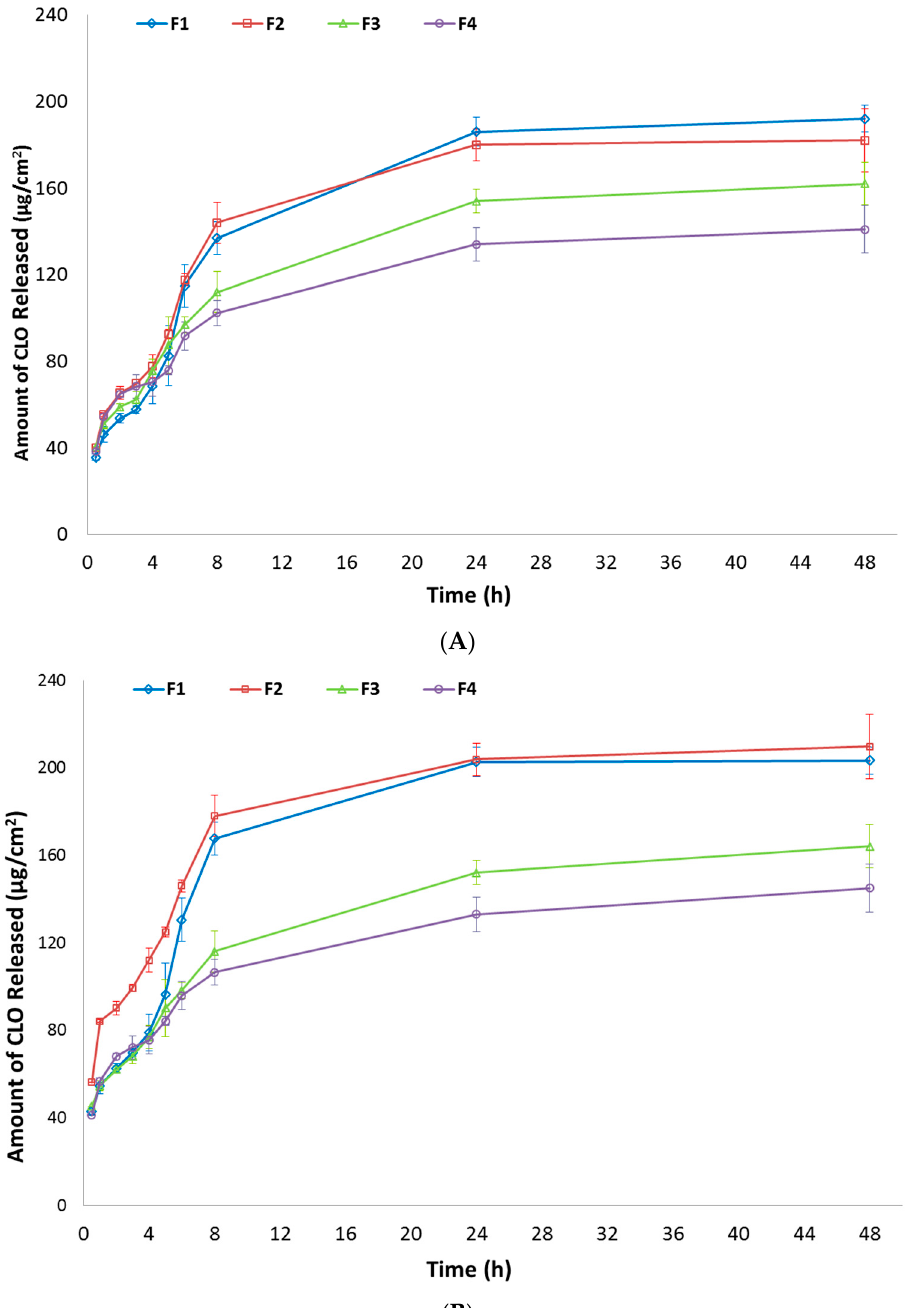
Figure 6. Viscosity of hydrogels F1–F4 in response to 4-week storage at 4 °C measured at shear rate 6 s − 1 at 25 °C (mean ± S.D.; n = 3).